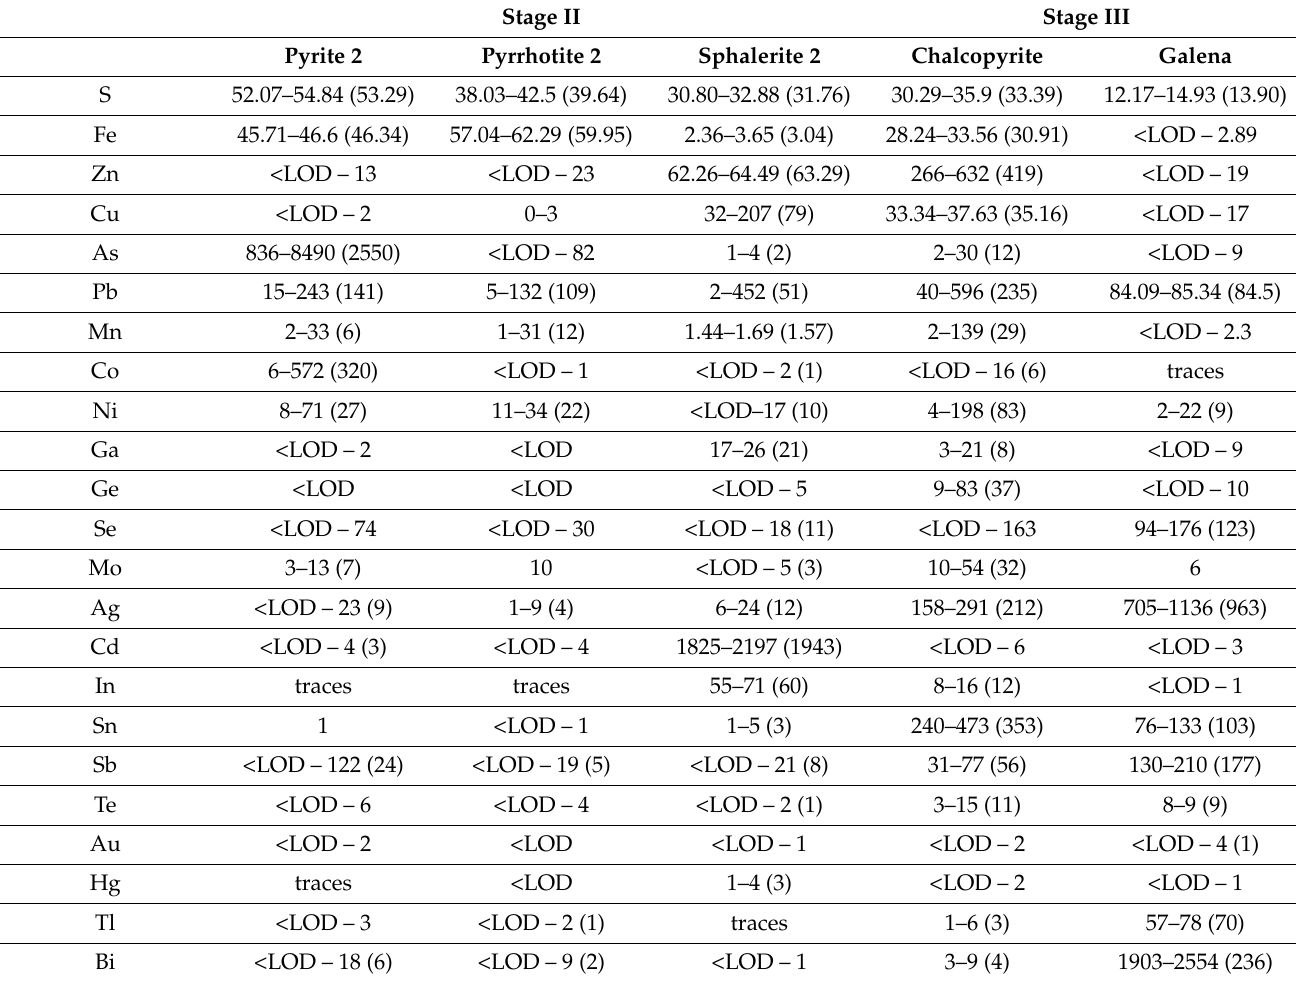
Table 3. LA-ICP-MS (in bold font) and EPMA (in italic font) data for the major sulfides at Koudiat Aïcha (stage II and stage III). Averages in brackets, < LOD: below detection limit, traces: close to the LOD. EPMA data in wt.%; LA-ICP-MS data in